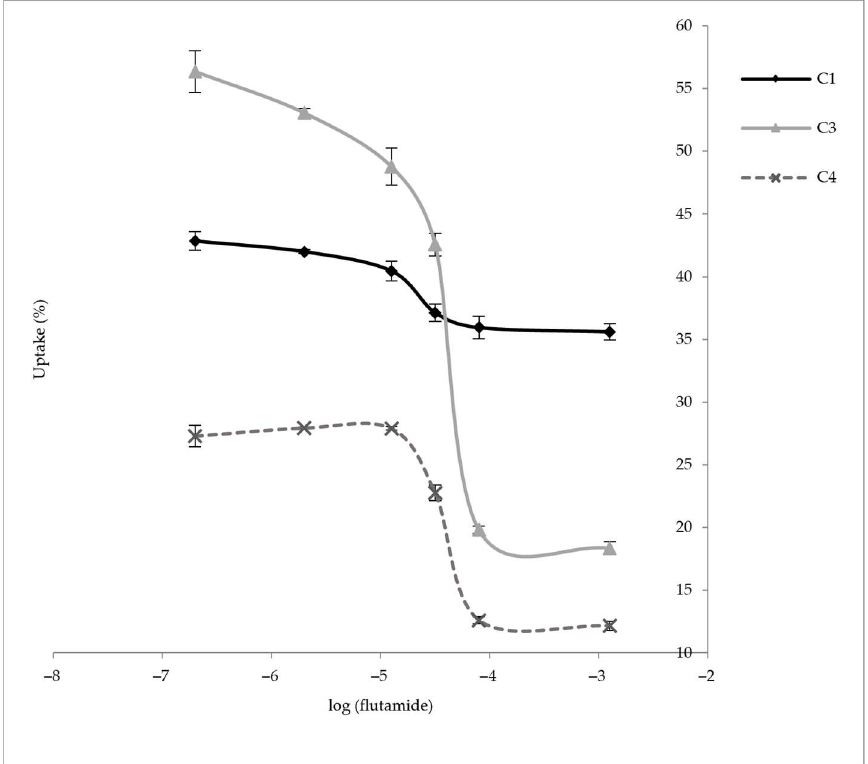
Figure 4. Binding assay graphs for complexes C1 (grey), C3 (black), and C4 (dotted line).